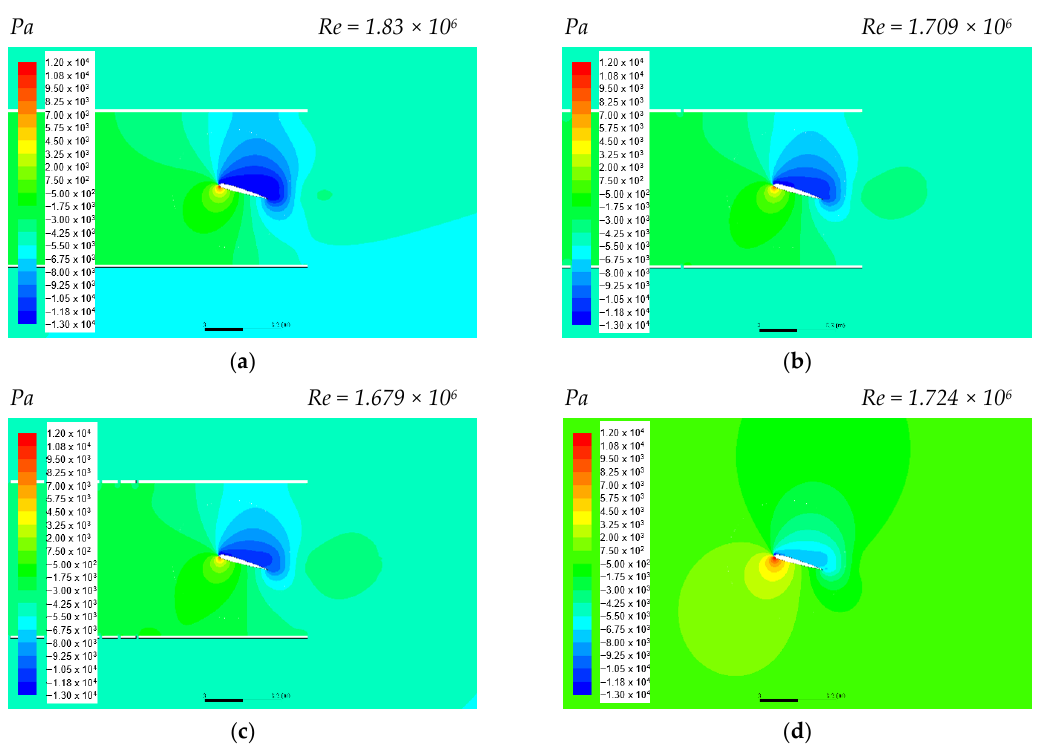
Figure 5. Distribution of static pressure for various perforation percentage values and for free flow (α = 16°, М = 0.4): ( a )—perforation 0% (solid walls); ( b )—perforation 7.5%; ( c )—perforation 15%; flow ( α = 16 ◦ , M = 0.4): ( a ) perforation 0% (solid walls); ( b ) perforation 7.5%; ( c ) perforation 15%; ( d )—free flow. ( d ) free